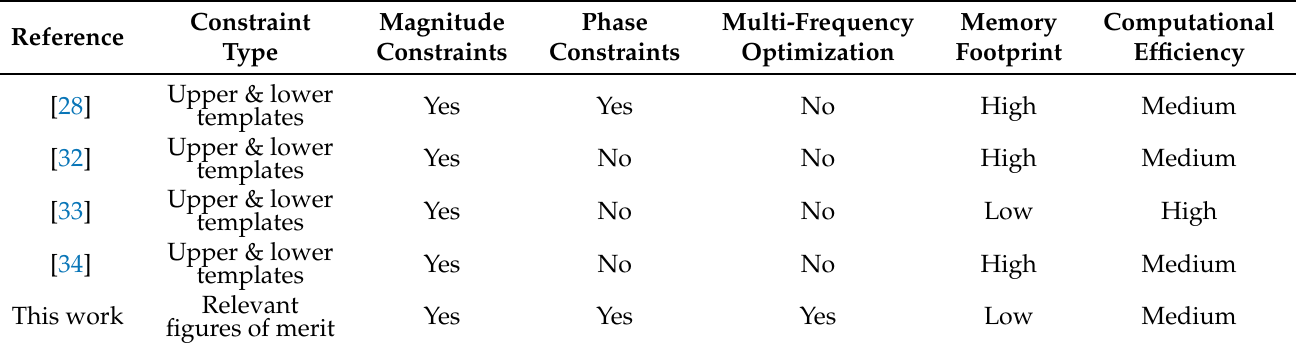
Table 3. Comparison of the proposed algorithm with other techniques described in the literature in terms of type of constraints, capabilities and computational